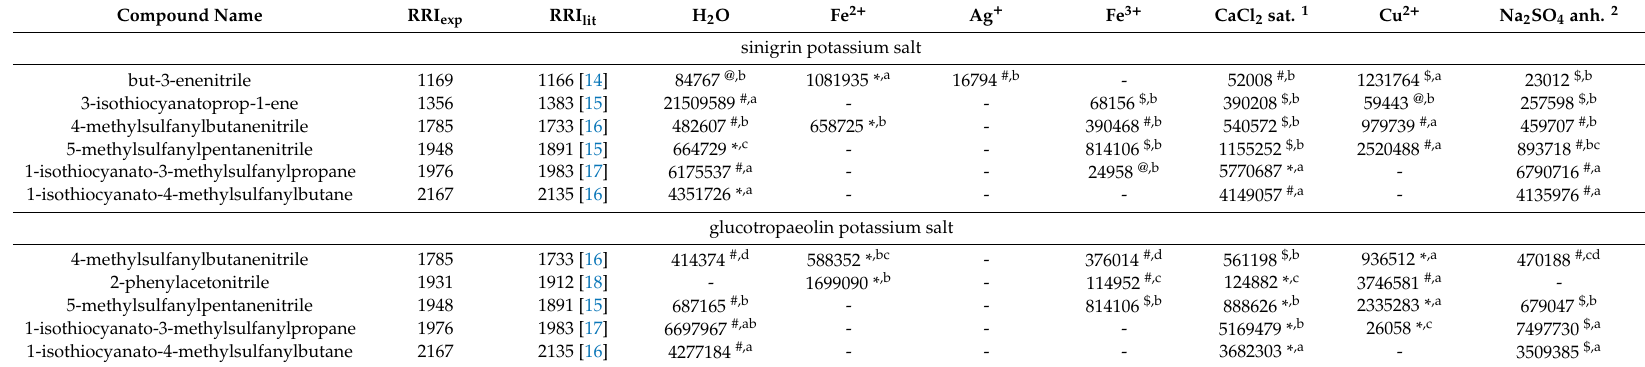
Table 1. Volatile compounds derived from glucosinolates in variable conditions within the kohlrabi